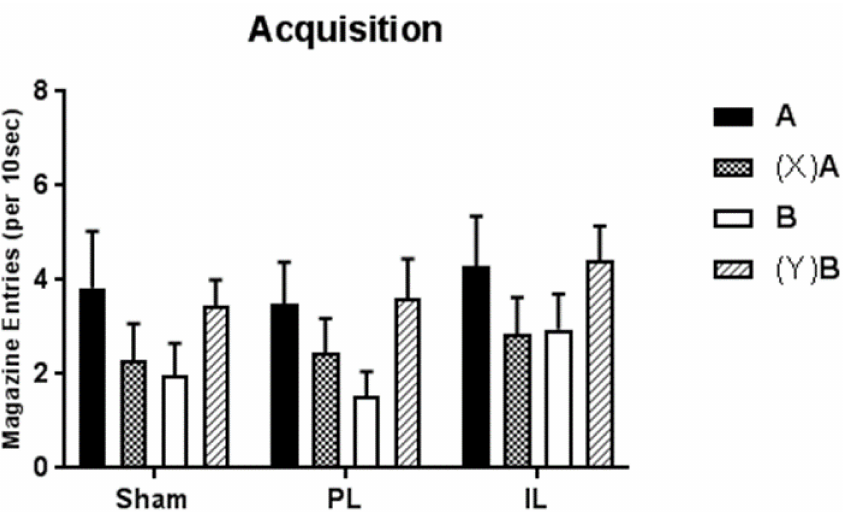
Figure 3. Rate (per 10 s; relative to baseline) of magazine entry during presentation of the target cue on feature-present and feature-absent trials of the feature negative ((X)A and A, respectively) and feature positive ((Y)B and B, respectively) discriminations. Error bars represent